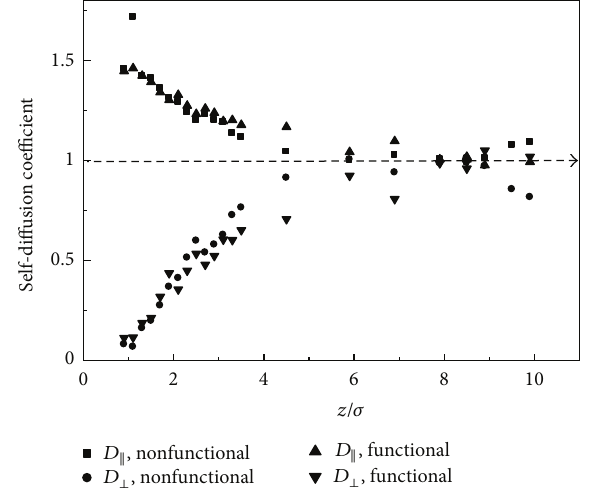
Figure 20: Self-diffusion coefficients ( 𝐷[𝜎 2 /𝜏])(𝑁 𝑝 = 6, 𝑇 = 0.5 ) as a function of distance from the surface for nonfunctional ( 𝜀 𝑝 𝑤 = = 5 ) and functional chain-ends ( 𝜀 𝑝 𝜀 𝑝 = 0, 𝜀 𝑤